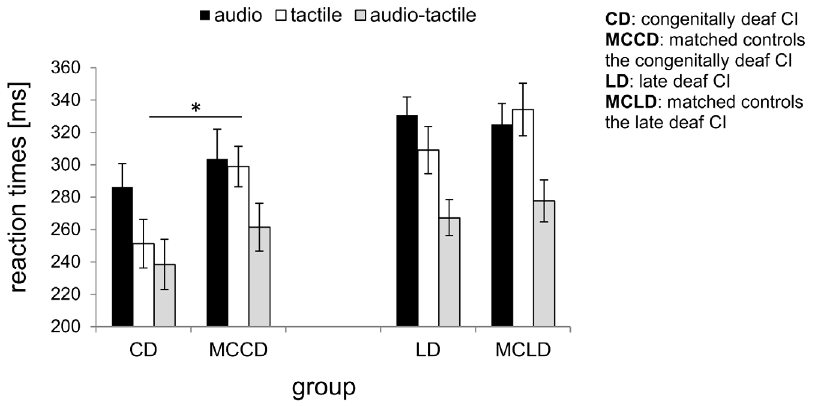
Figure 1. RT for unimodal auditory, unimodal tactile and bimodal. Mean reaction times (in ms, with error bars indicating the standard error) for each condition (unimodal auditory, unimodal tactile and audio-tactile), separately for the group of congenitally deaf CI recipients and their age- matched controls (left panel), and late deaf CI recipients and their age-matched controls (right panel). Note that despite all participants being faster for bimodal compared to unimodal stimuli, congenitally deaf CI recipients were faster for unimodal tactile stimuli compared their matched controls.